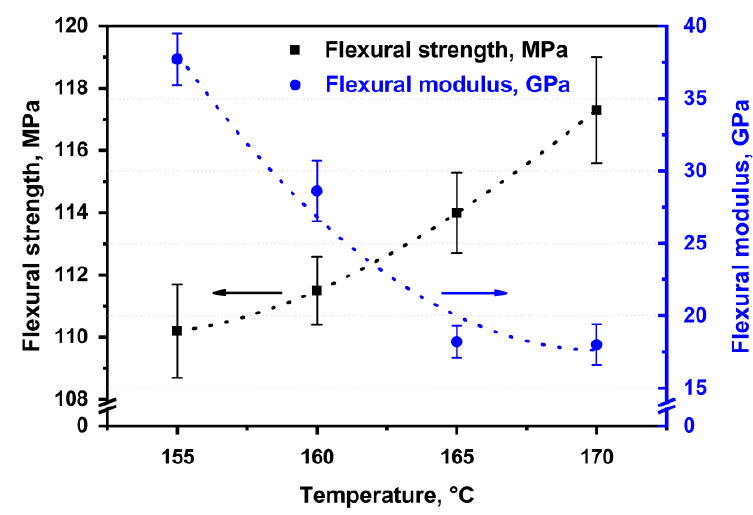
Figure 4. Flexural strength and flexural modulus of the self-reinforced composite based on UHMWPE produced at 25 MPa and different temperatures